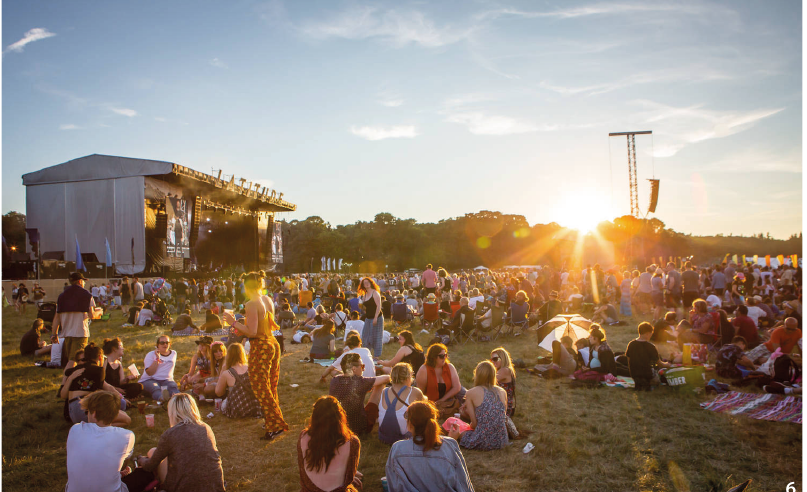
Figure 6 Latitude Festival in Henham Park, Suf- folk, UK (Source: Latitude Festival official).